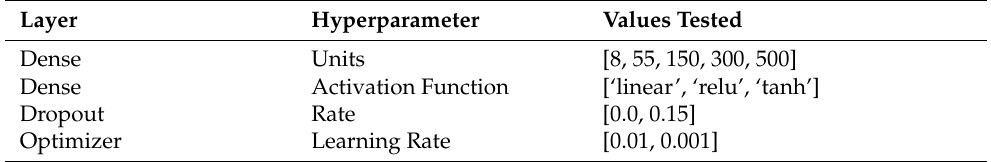
Table 5. Hyperparameters tested in Keras tuner.